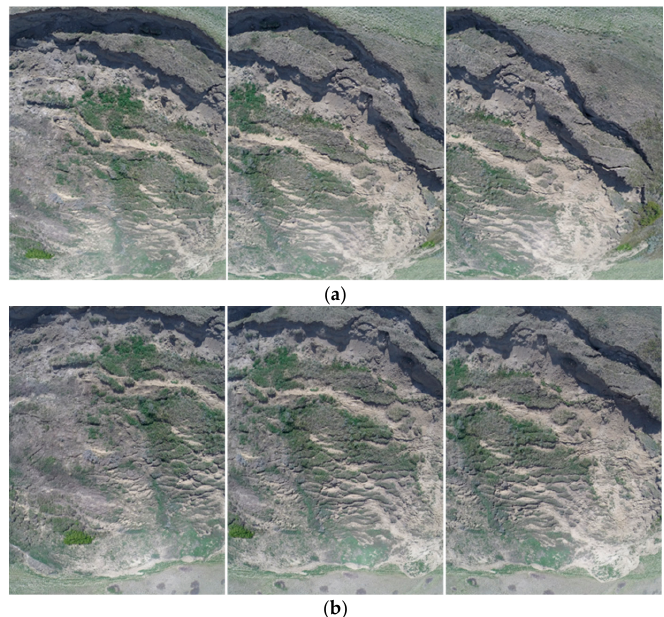
Figure 6. Sample set of UAV images of the experimental dataset: ( a , b ) showing sequence images with 80% overlap along the flight path, as well as showing the sidelap between adjacent flight paths. Table 1. Overview of all performed UAV flights for the study area, Lethbridge, Alberta in May 2014 and May 2015.